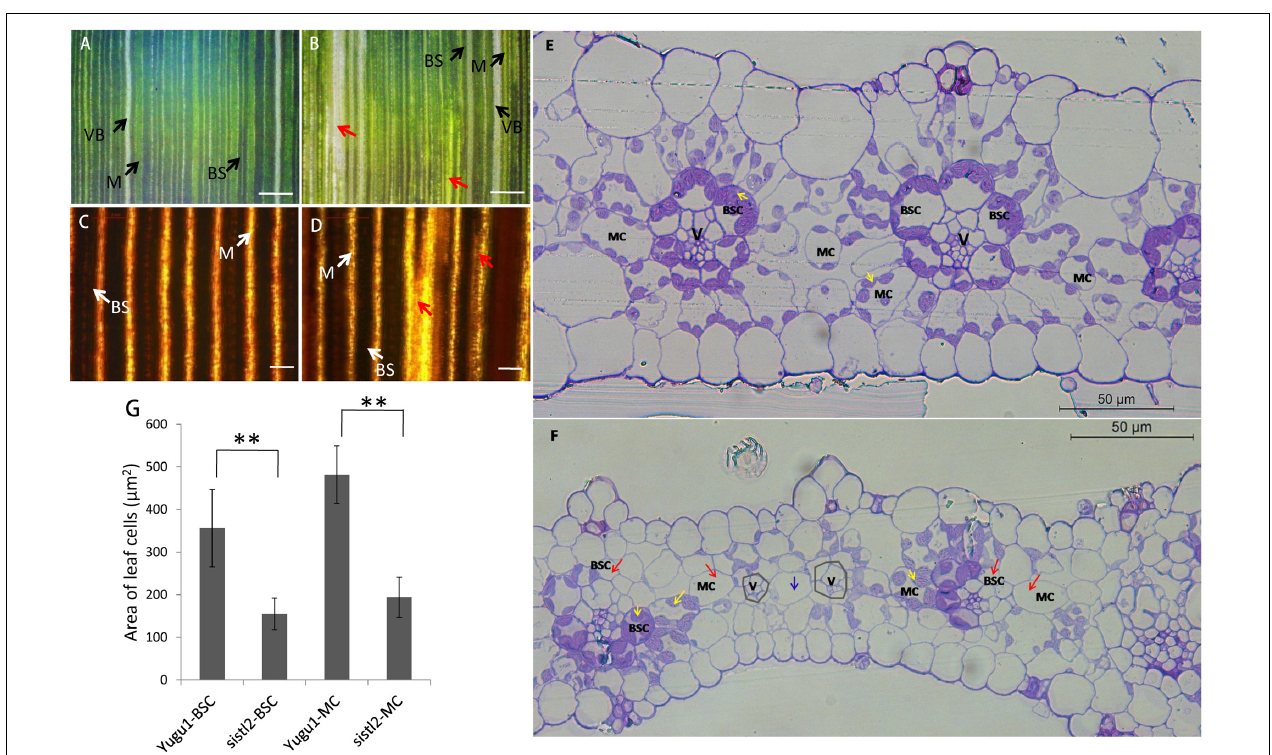
FIGURE 2 | Leaf structure of Yugu1 and sistl2 . (A,B) The leaves of Yugu1 and sistl2 observed by portable digital microscope. BS, bundle sheath. M, mesophyll tissue. Red arrows show abnormal leaf veins. Bars: 500 µ m. (C,D) The leaves of Yugu1 and sistl2 dyed by I 2 –KI and viewed by using a light microscope. Red arrows show abnormal leaf veins. BS, bundle sheath; M, mesophyll tissue. Bars: 100 µ m. (E,F) Leaf cross sections of Yugu1 and sistl2 , respectively. Yellow arrows, chloroplasts in normal BSCs/MCs; Red arrows, BSCs/MCs contain no chloroplasts; Gray polygons show the leaf veins with undeveloped BSCs. Blue arrow, only one MC between two leaf veins (V). The type of the cell between two leaf veins was judged by the structure of its chloroplast as elucidated in Supplementary Figure R1 . (G) The areas of BSCs and MCs in Yugu1 and sistl2 . Twenty medium-sized cells from three horizons were calculated. The statistical analysis was performed by t -test. ∗∗ P =